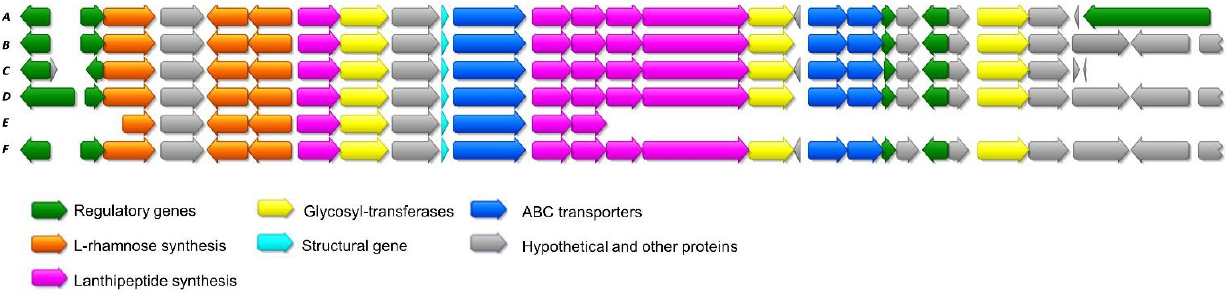
Figure 5. Schematic representation of the alignment of cacaoidin BGC from Streptomyces cacaoi CA-170360 and the highly homologous clusters found in NCBI. All of them belong as well to strains of S. cacaoi . A: S. cacaoi CA-170360; B: S. cacaoi subsp. cacaoi NBRC 12748; C: Streptomyces sp. NRRL S-1868; D: Streptomyces sp. NRRL F-5053; E: S. cacaoi subsp. cacaoi NRRL B-1220; F: S. cacaoi subsp. cacaoi OABC16.